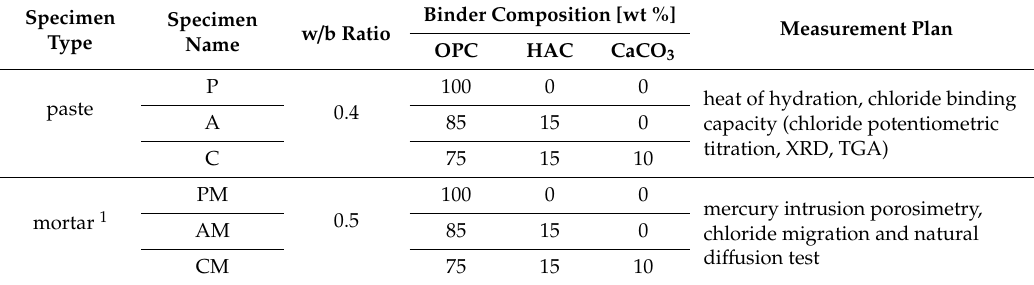
Table 2. Mix proportions of